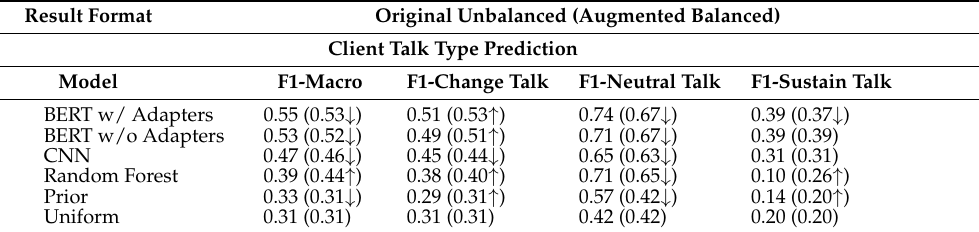
Table 16. Macro F1 and per-class F1 scores of client talk type prediction. All results averaged from 5-fold cross-validation. ↑ / ↓ : performance increase/decrease by using Augmented Balanced compared to using Original Unbalanced.